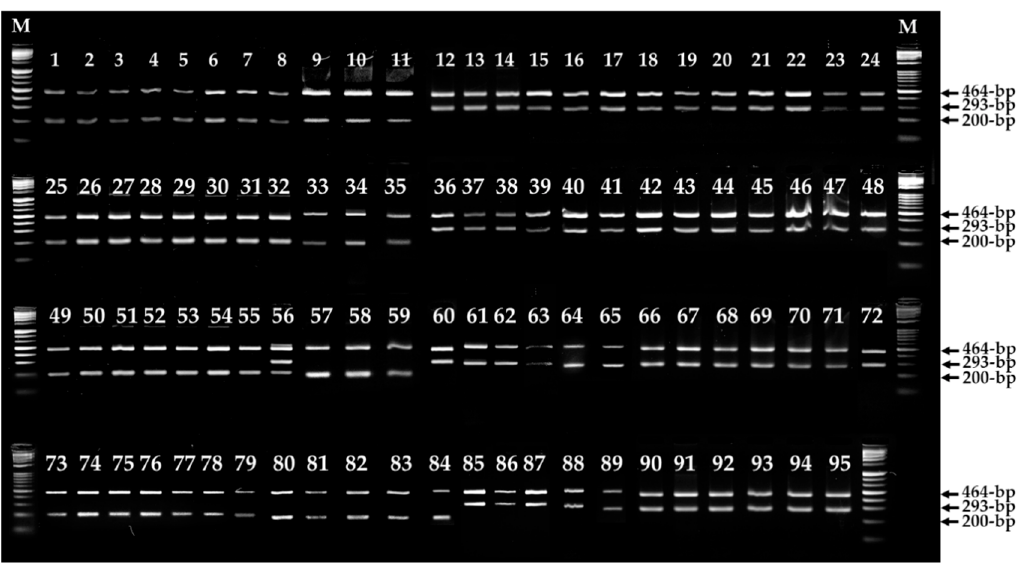
Figure 4. Amplification refractory mutation system (ARMS) PCR of Fvpal1 in 95 Flammulina velutipes strains (Table 1). Non ‐ white and white strains of F. velutipes showed 464 bp and 200 bp, 464 bp and 293 bp PCR products, respectively. A heterozygous strain (No. 56, F. velutipes ASI4175) showed all three amplification products: 464 bp, 293 bp, and 200 bp. M, size marker (1 kb ladder, TNT Re ‐ search).